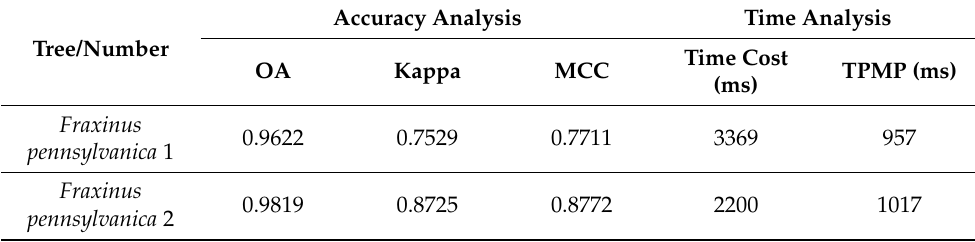
Table 7. The accuracy and efficiency analysis of two Fraxinus pennsylvanica trees classification results.